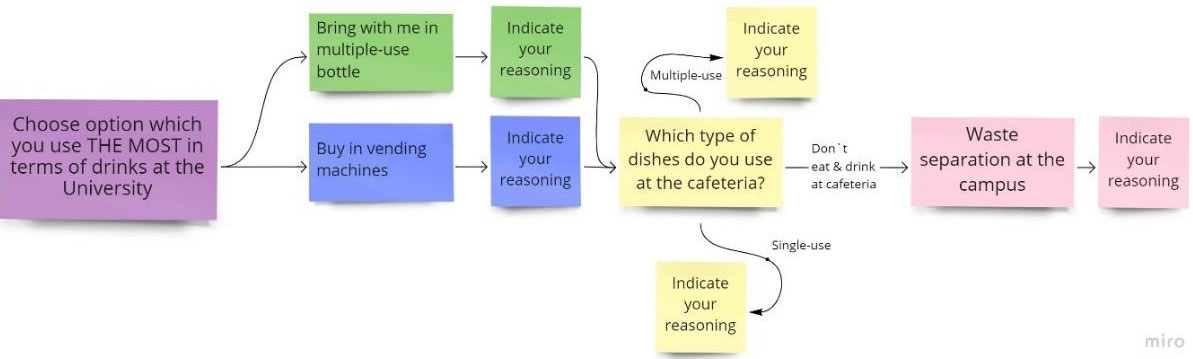
Figure 3. Skip-logic algorithm for questions of “waste Figure 3. Skip ‐ logic algorithm for questions of “waste category”.